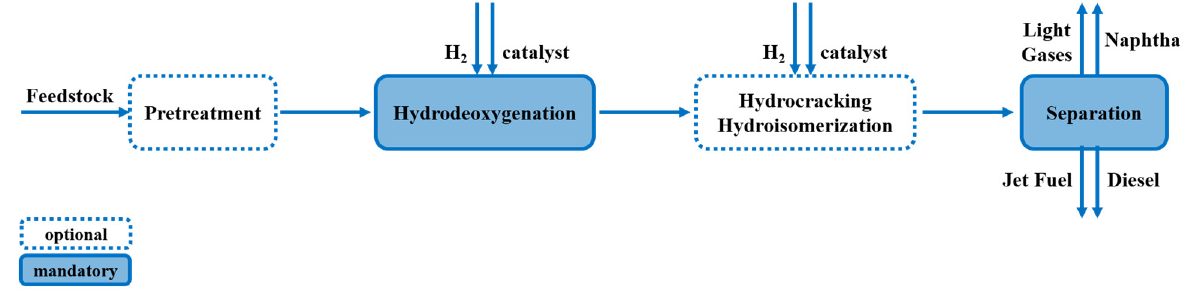
Figure 2. Simplified Hydroprocessing of Esters and Fatty Acids (HEFA) for jet biofuel production. Adapted from [41].